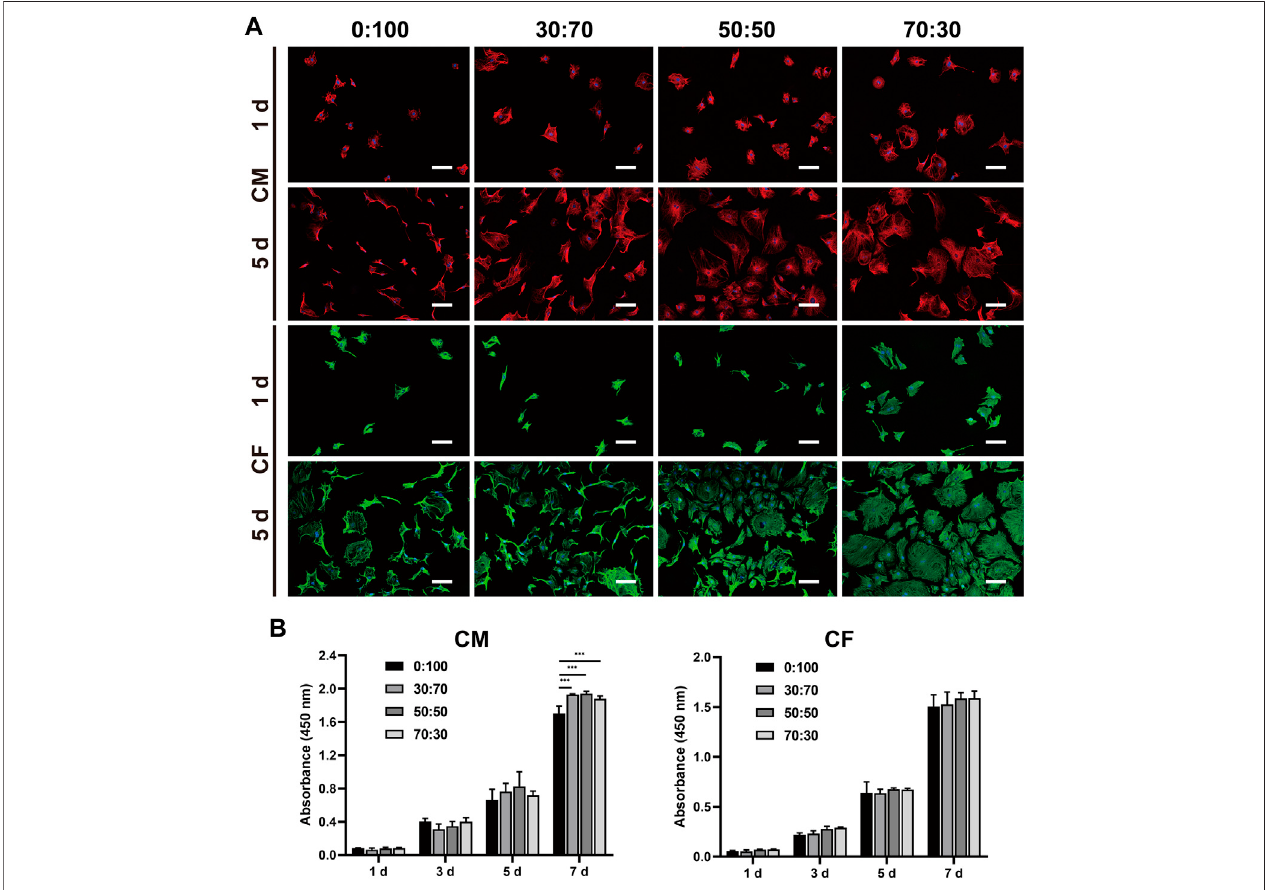
FIGURE 5 | (A) Representative immuno fl uorescence staining images of cardiomyocytes and cardiac fi broblasts cultured on different membranes for one and 5 days. Blue: nucleus. Red: cTNT. Green: vimentin. Scale bars (cid:1) 100 μ m. (B) Proliferation of cardiomyocytes and cardiac fi broblasts cultured on different nano fi brous membranes for one, three, fi ve, and 7 days. (*** p <